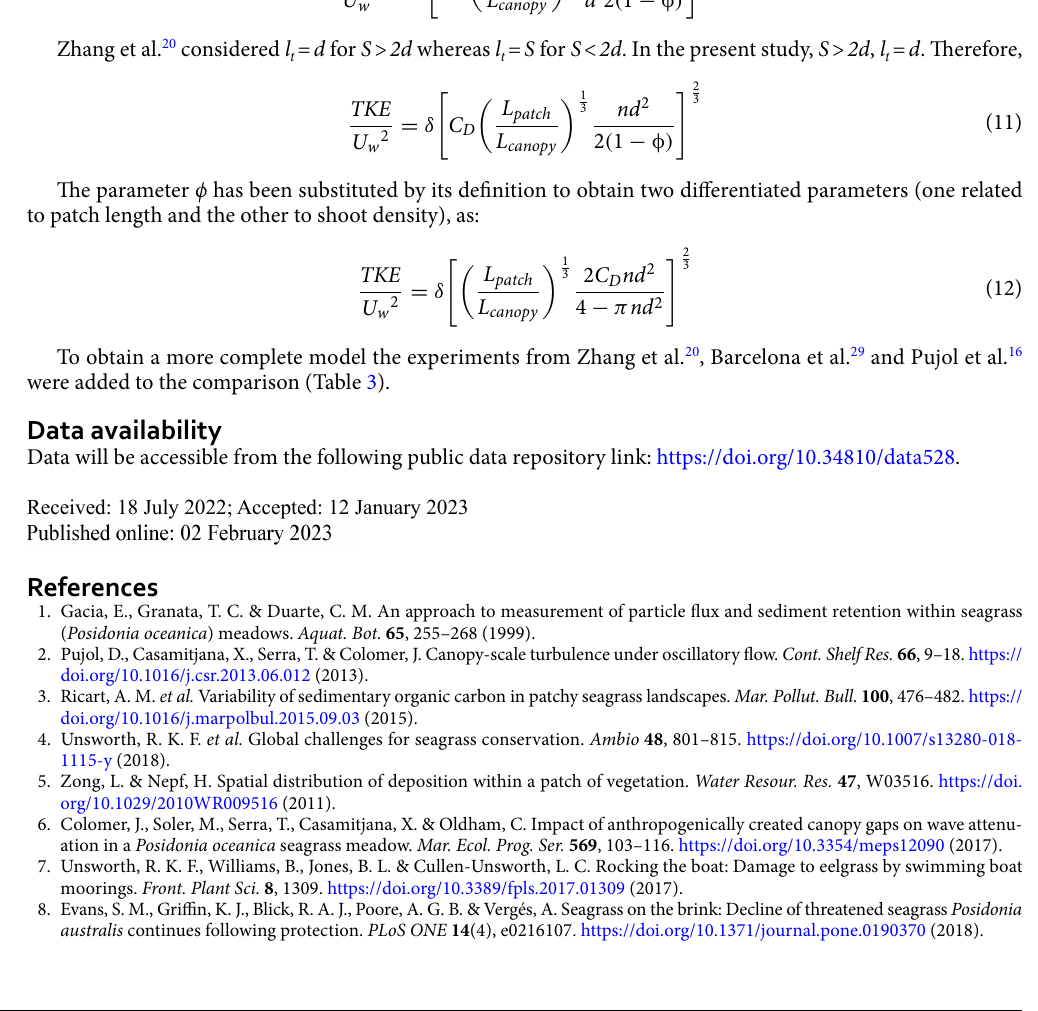
Zhang et al. 20 considered l t = d for S > 2d whereas l t = S for S < 2d . In the present study, S > 2d , l t = d . Therefore,